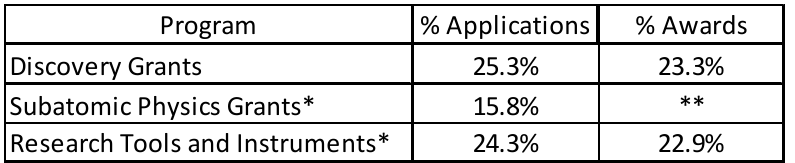
Member of a Visible Minority, 2020